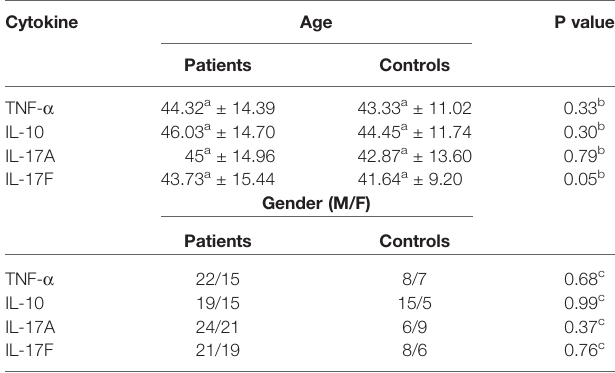
TABLE 2 | Characteristics of AS patients and controls selected for cytokines